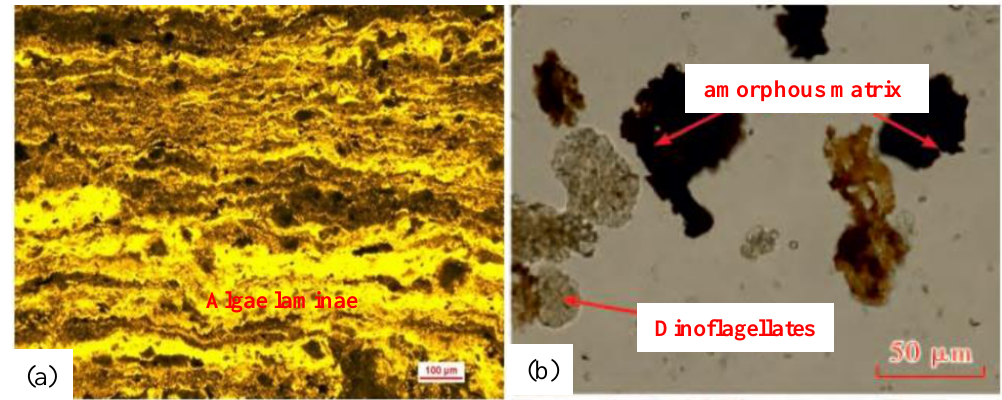
Figure 3. Hydrocarbon-generating parent material composition of source rocks of the Fengcheng Formation in Mahu Sag. ( a ) Well Fn 8, 3596 m P 1 f, Algae laminae under UV fluorescence. ( b ) Well Fc 011, 3163 m P 1 f, Dinoflagellates and amorphous matrix under plane-polarized light.